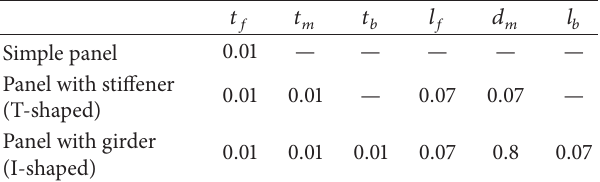
Table 1: Parameter for the substructures (unit: